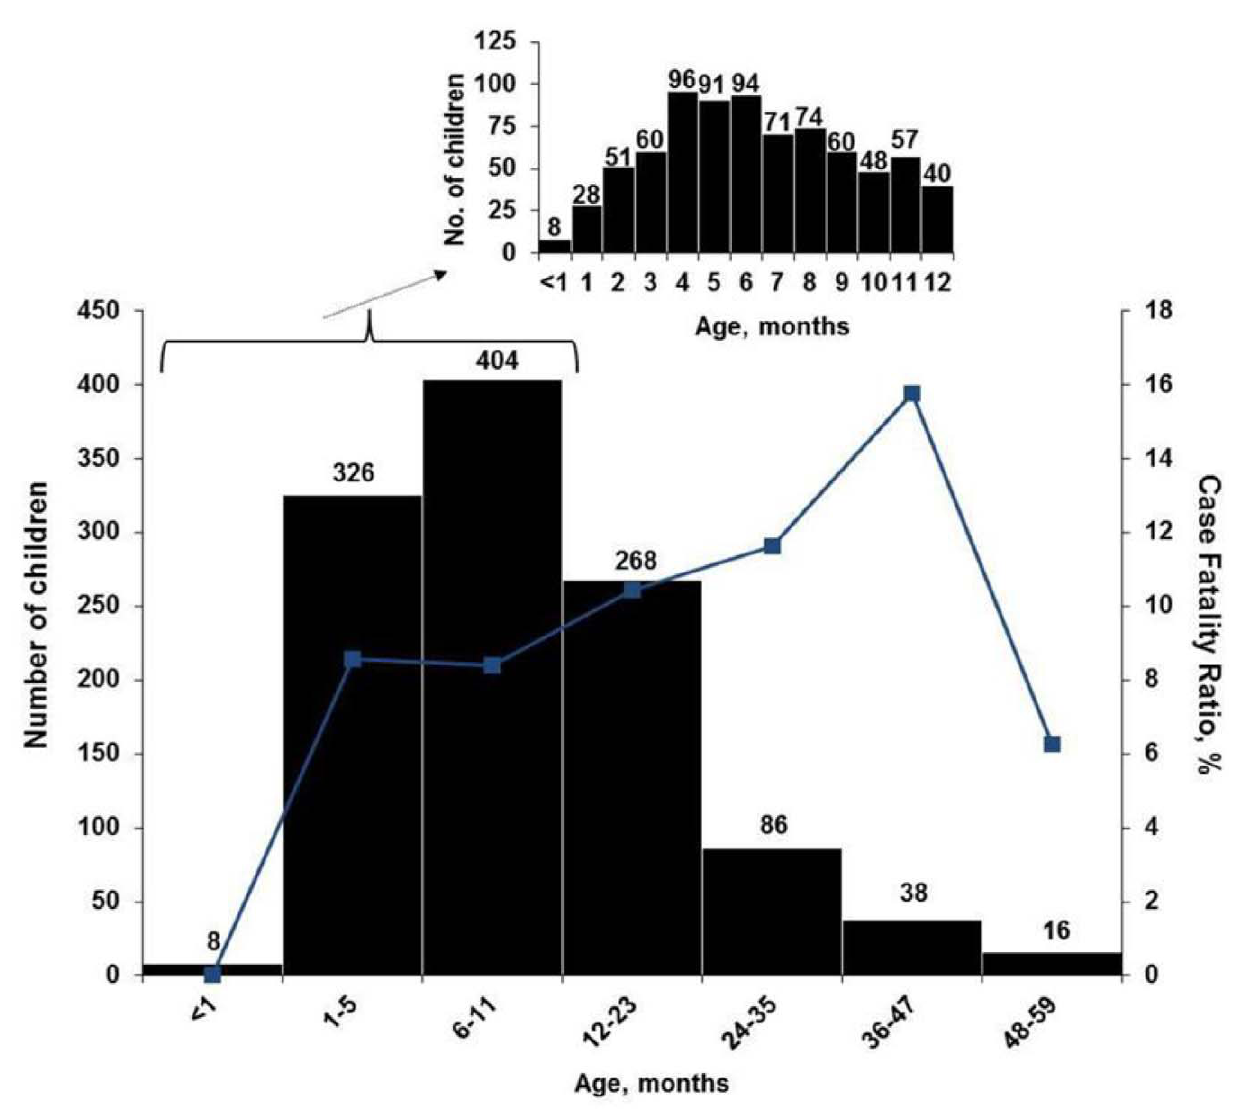
Figure 1. Age distribution (bars) and age-specific CFR (line) of 1,146 children hospitalized with diarrhea, western Kenya 2005–2007. Inset, age distribution by 1-mo periods, for children aged , 1 to 12 mo old ( n =778).